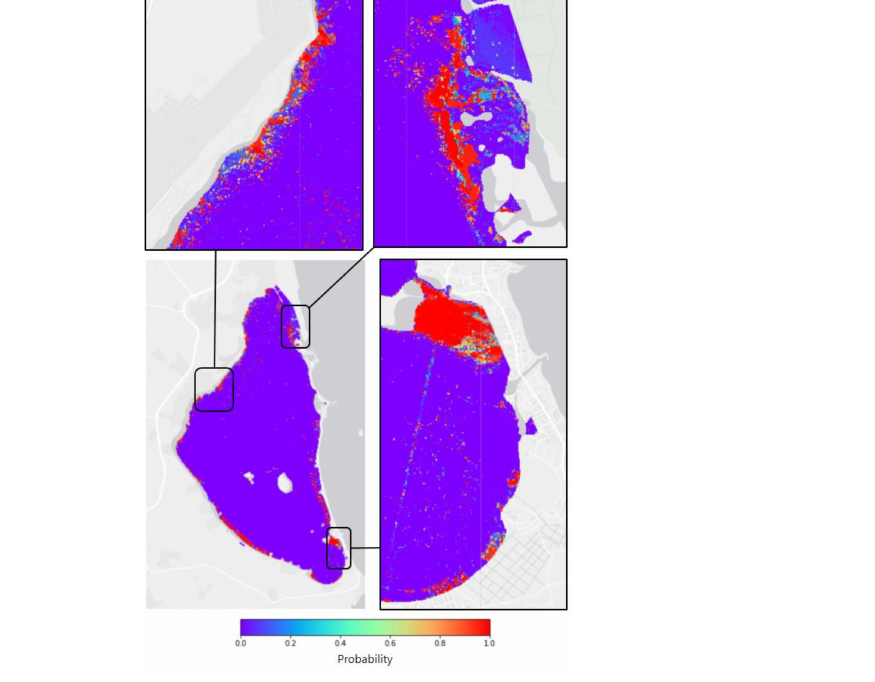
Figure 7. Probability of classification on 25 April 2022. Probability is used as an indicator of confidence on the prediction made by the classification algorithm presented in the previous section. The probability color scale ranges from 0 in purple (“no macroalgae” class) to 1 in red (“macroalgae”